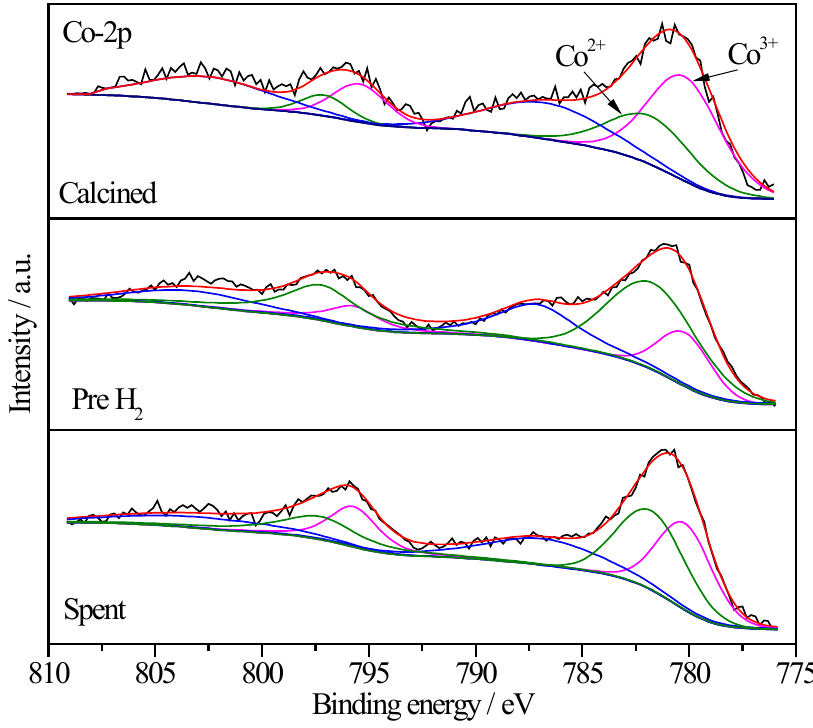
Figure 17. Co-2p XPS spectra of the calcined, reduced, and spent Pt/CoO x /Al 2 O 3